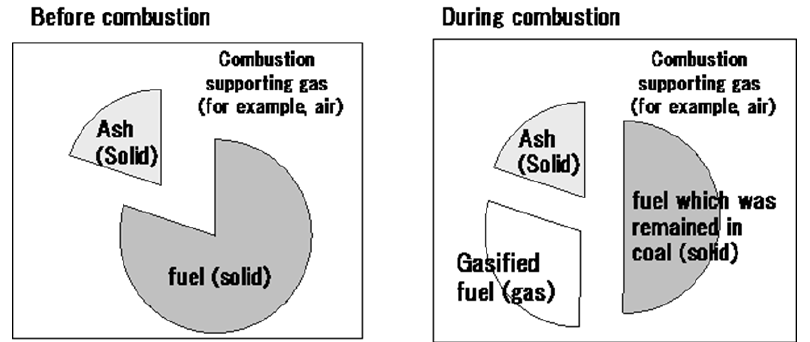
Figure 1. Definition of gas phase stoichiometric ratio ( SRgas